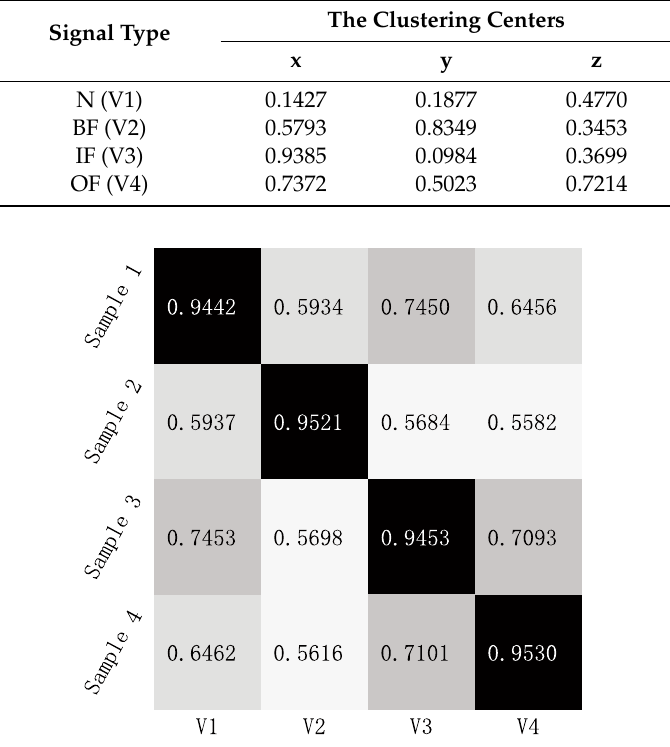
Figure 6. Average Hamming approach degree of each sample set.